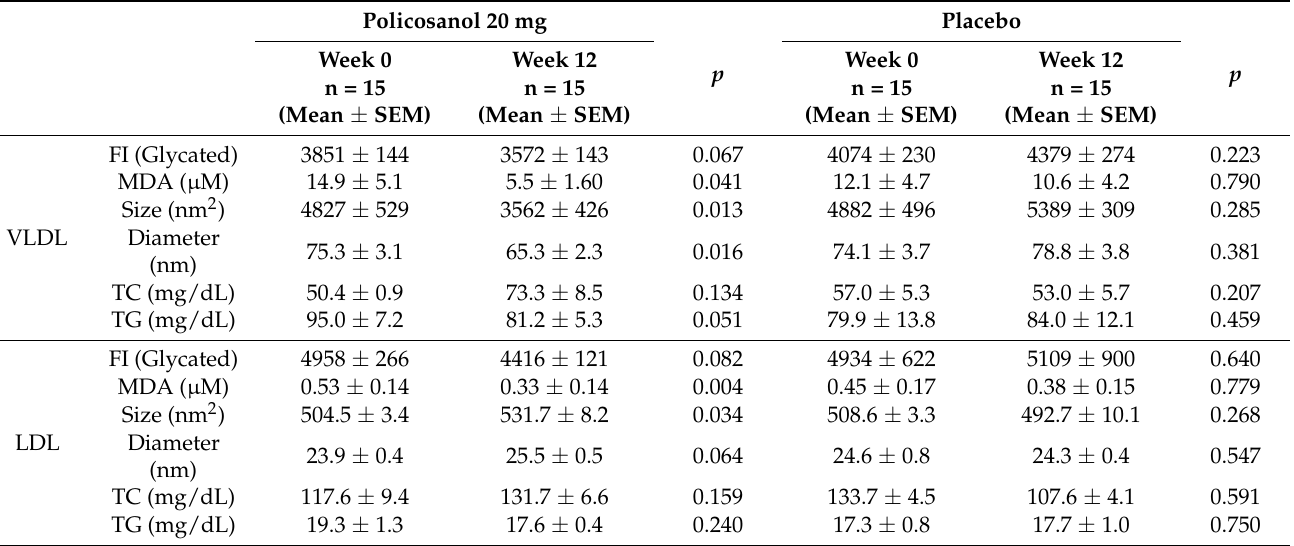
Table 3. Lipid compositions, oxidized extent, and extent of VLDL and LDL glycation between the policosanol and placebo groups.